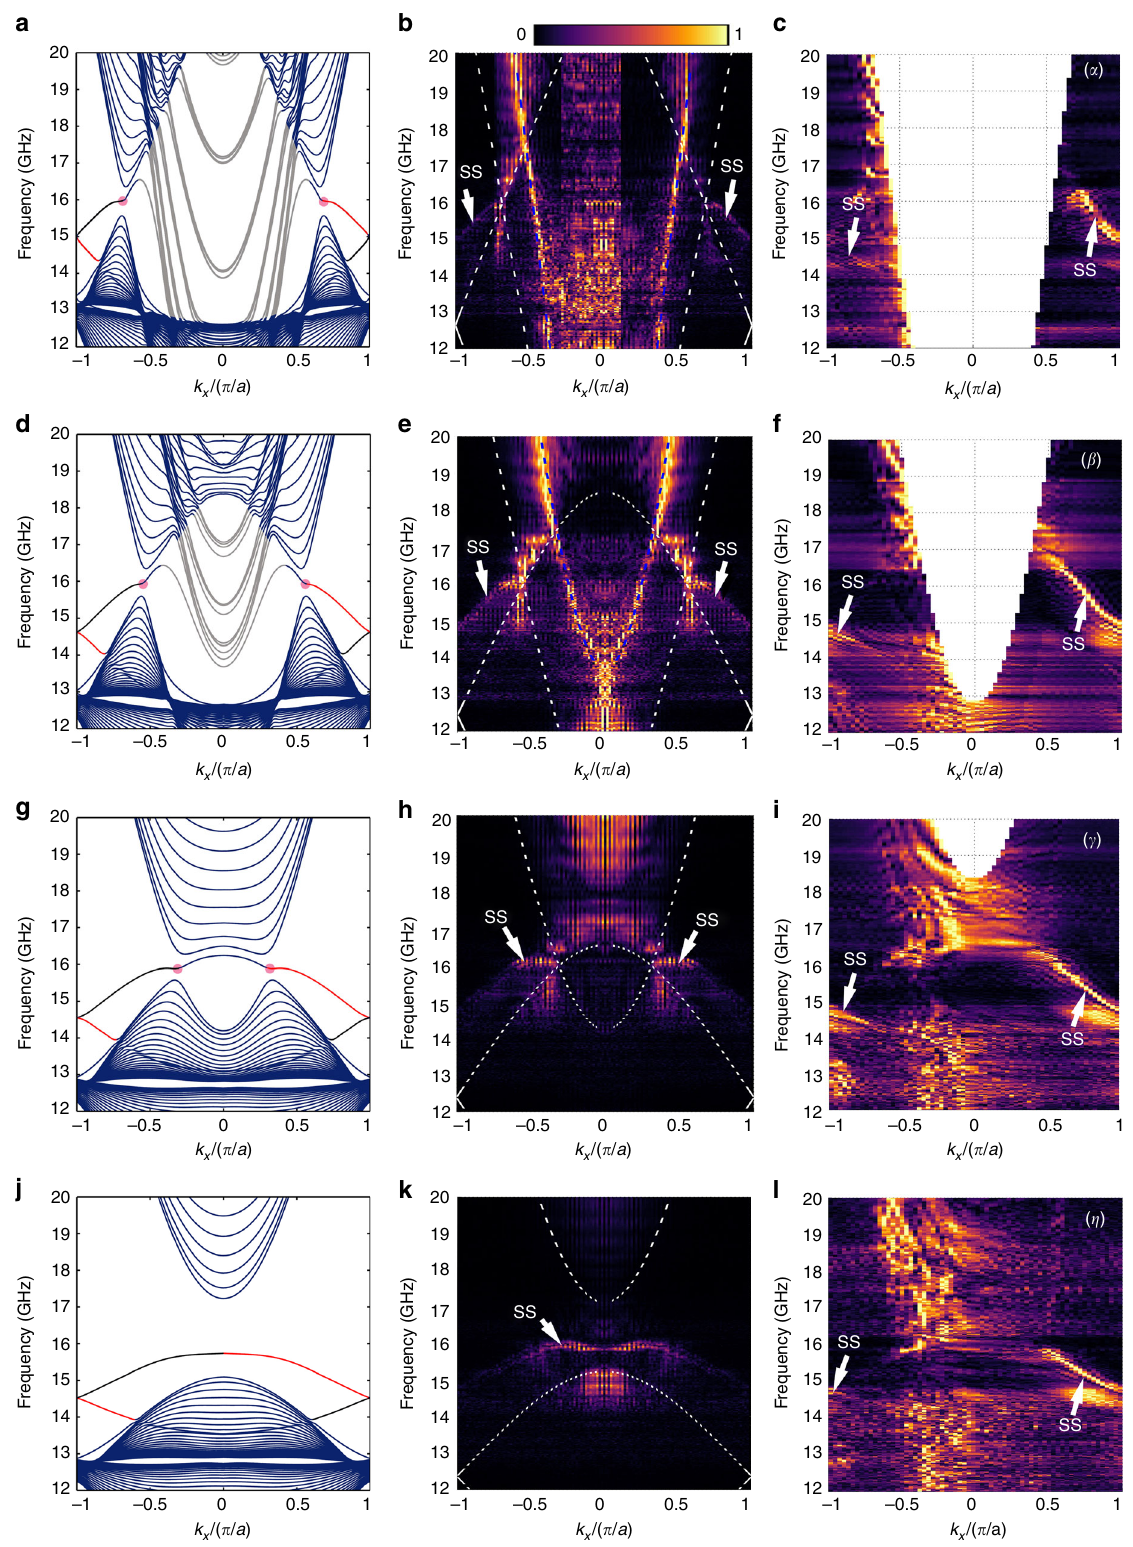
Fig. 3 Band structure of the nodal line metacrystal. a – c Simulated and measured band structure of the 30-layers metacrystal along the ( α ) line. In a the NL is denoted by the magenta dots in the two valleys. Surface states (SSs) are colored in red and black according to the sign of their group velocities. b Band structure extracted from the E z fi eld measured on the top surface. The cone-shaped valleys touch at around 16 GHz, indicating the bulk states of the NL. SSs are also excited (indicated by the white arrows) through scattering of bulk states at the sample ’ s edge. c SSs measured by placing a y -polarized source dipole close to the center of one edge of the top surface of the metacrystal. Note that only the red branch SSs in a are observed. Results within light cone are excluded for better visualization of the SSs. In a and b , the gray-colored bands correspond to extra waveguides modes in air which are not at present in the experiments. Results on ( β ), ( γ ), and ( η ) lines are given in d – f , g – i , and j –